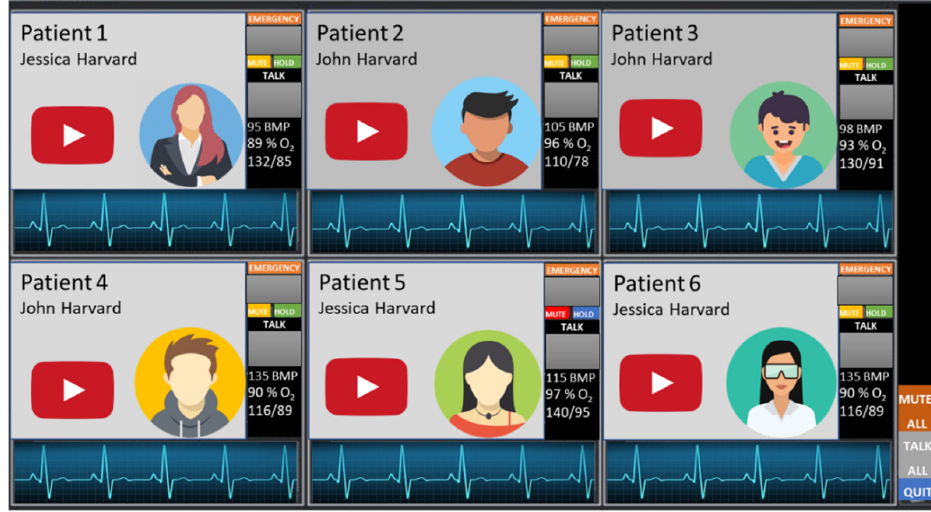
Figure 7. Demo design for physician HMI, which shows six patients in a window.